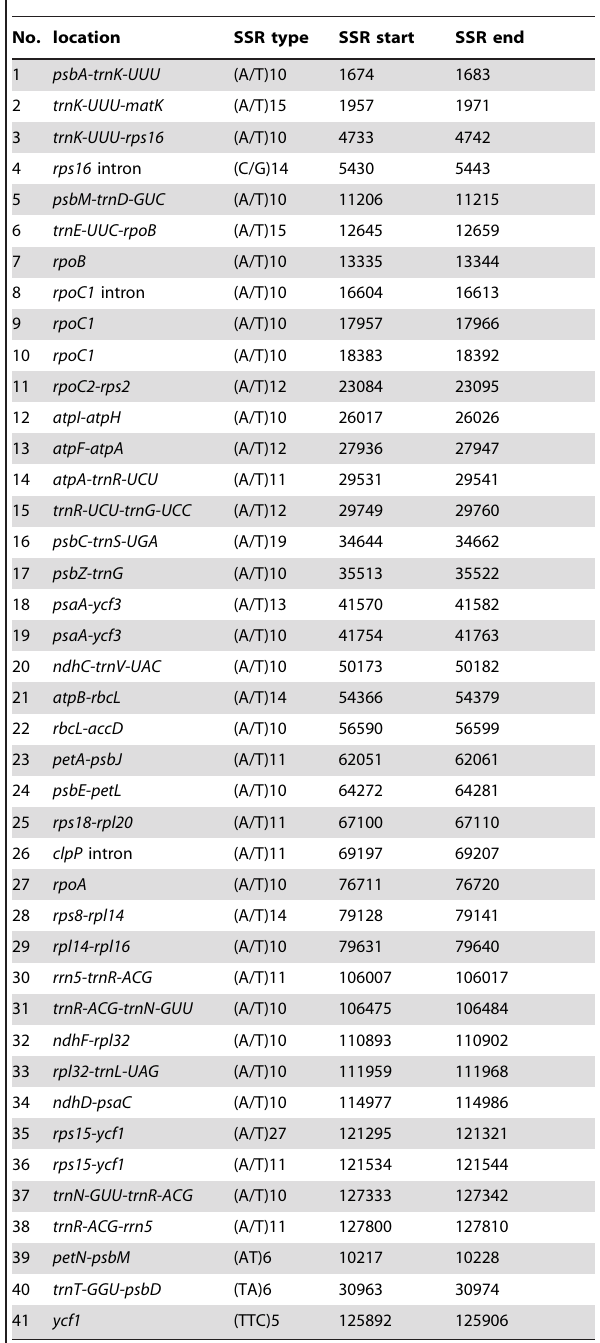
Table 3. Simple sequence repeat in Artemisia frigida chloroplast genome.